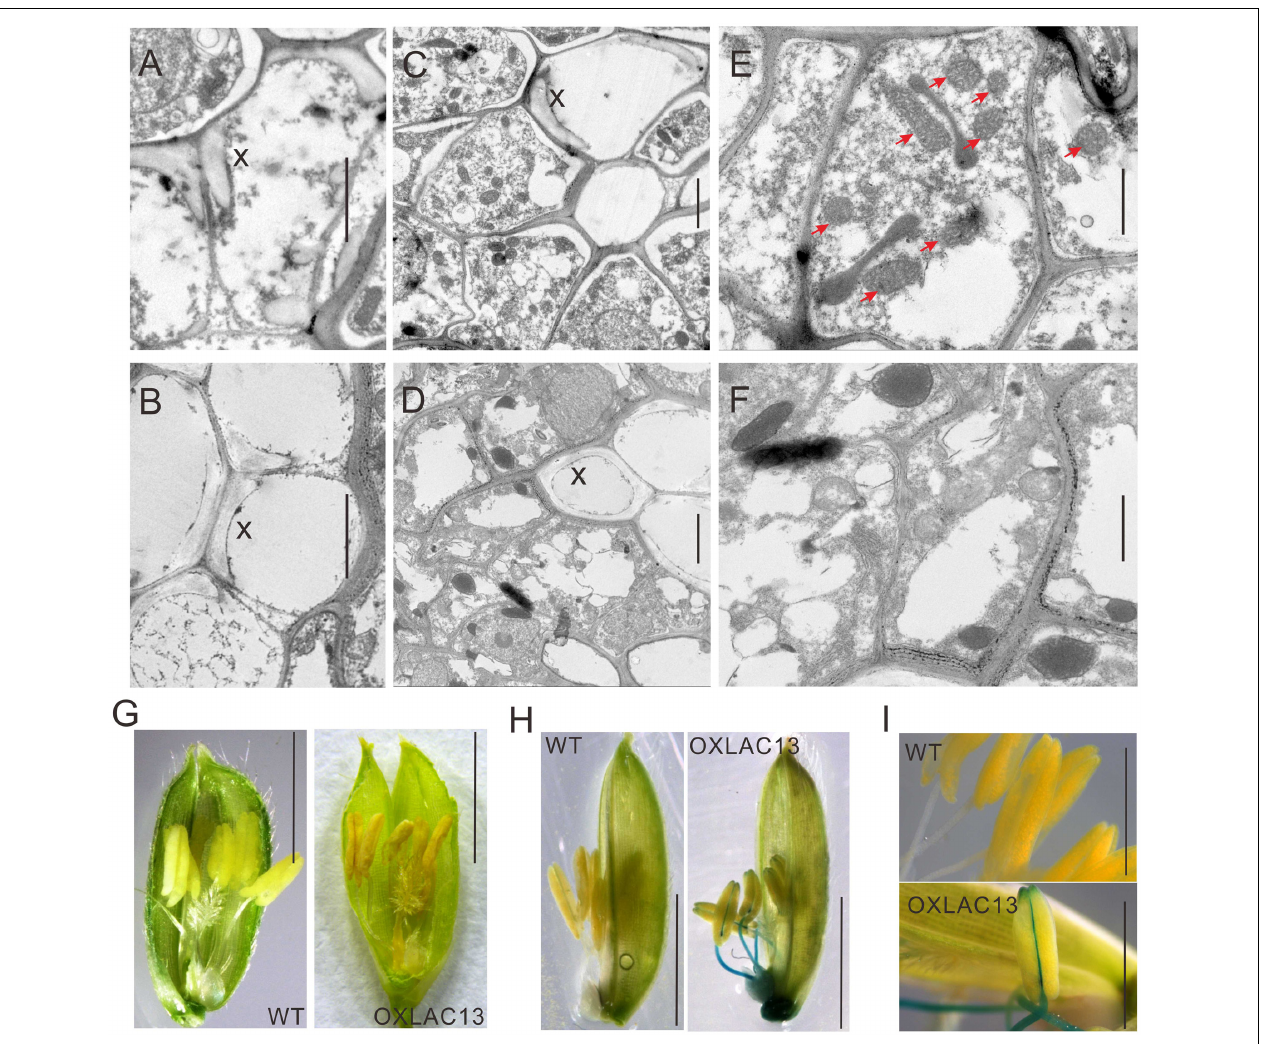
FIGURE 3 | Transmission electron micrographs of vascular and ROS accumulation in WT and OXLAC13 anthers. (A,B) The secondary xylem of WT (A) and OXLAC13 (B) anther vascular. Scale bars, 2 µ m. (C,D) The phloem of WT (C) and OXLAC13 (D) anther vascular. Scale bars, 2 µ m. (E,F) Magnified image of the phloem of WT (E) and OXLAC13 (F) . The red arrows show the normal mitochondria in WT phloem ( E ). Scale bars, 1 µ m. X, secondary xylem. (G) Flowers of WT and OXLAC13 plants at the mature stage, showing that the OXLAC13 flowers turn brown at this stage. Scale bars, 4 mm. (H) TMB staining of H 2 O 2 production at the late anther development stage showing blue color. Scale bars, 4 mm. (I) A higher-magnification image of the anthers at the late anther development stage after TMB staining. Scale bars, 2